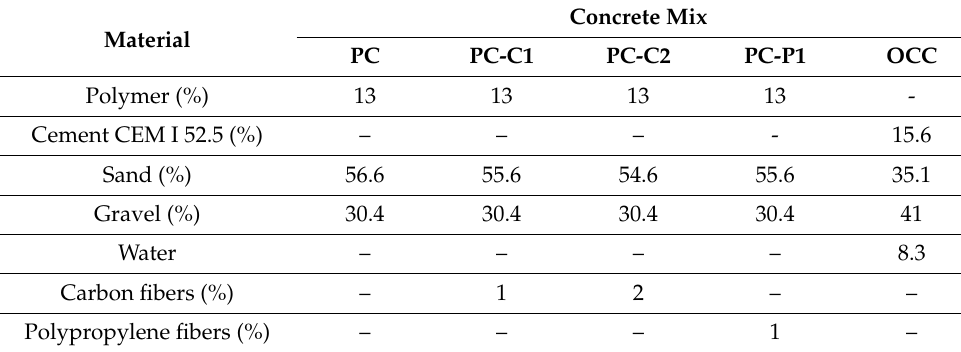
Table 2. PC and OCC mixes with the varying fiber’s content.